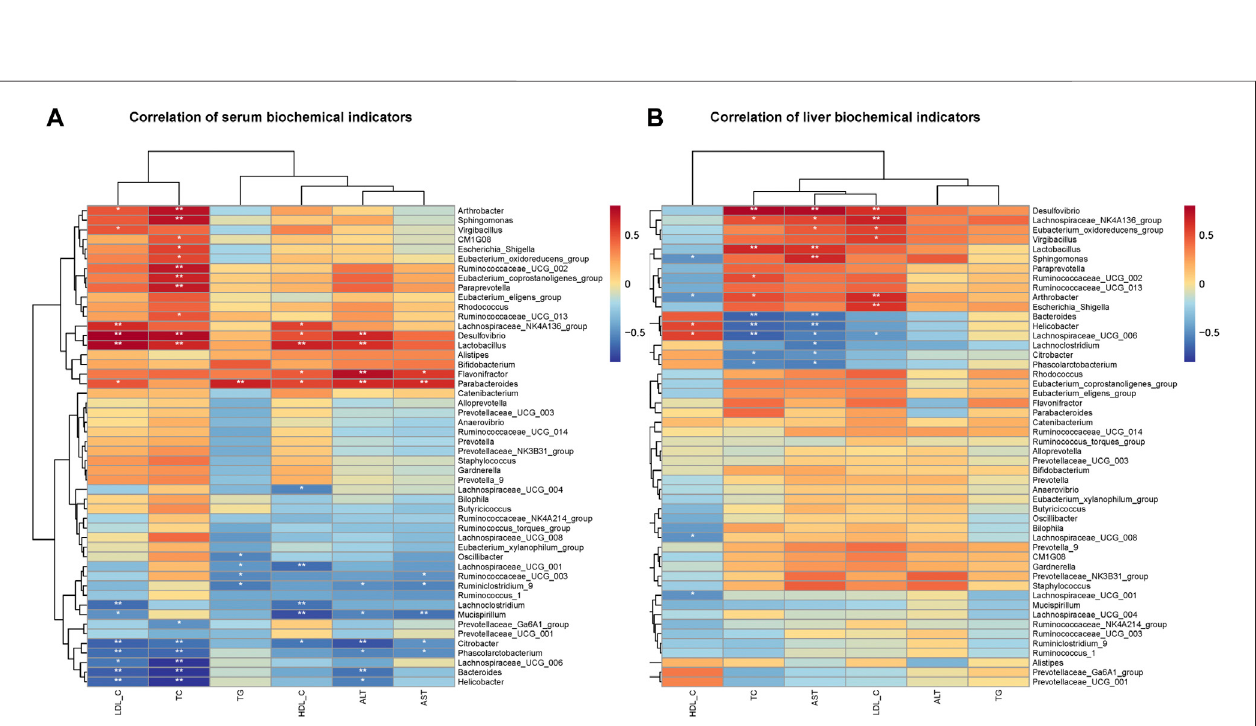
FIGURE8| CorrelationanalysisofIMwithserumandliverbiochemicalparametersinmice. (A) Correlationanalysisofserumbiochemicalindicators. (B) Correlation analysis of liver biochemical indicators.